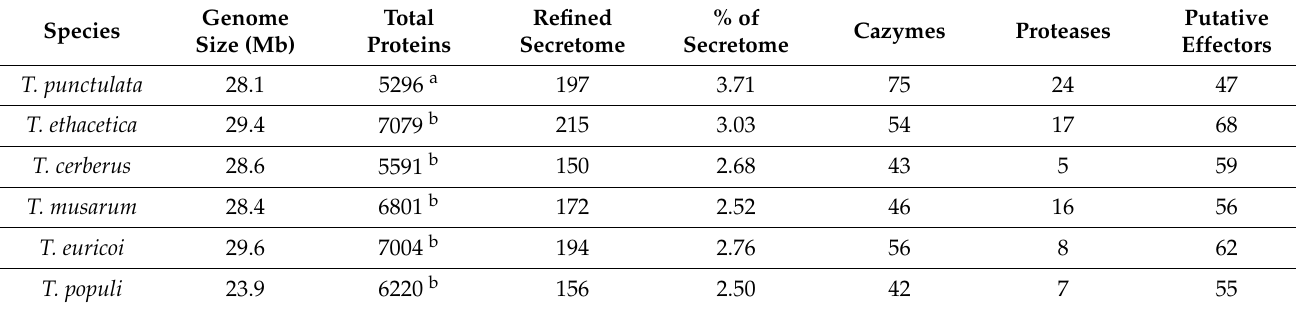
Table 1. Overview of Secretome of T. punctulata and its closely related species.